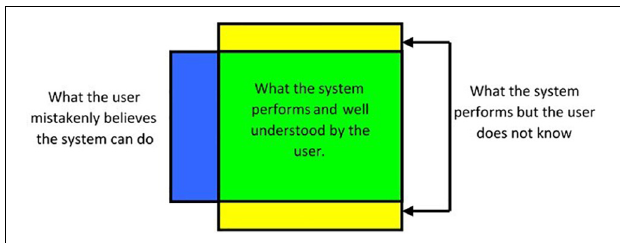
FIGURE 3 | Real assistance capacity of an automated system based on the knowledge of the